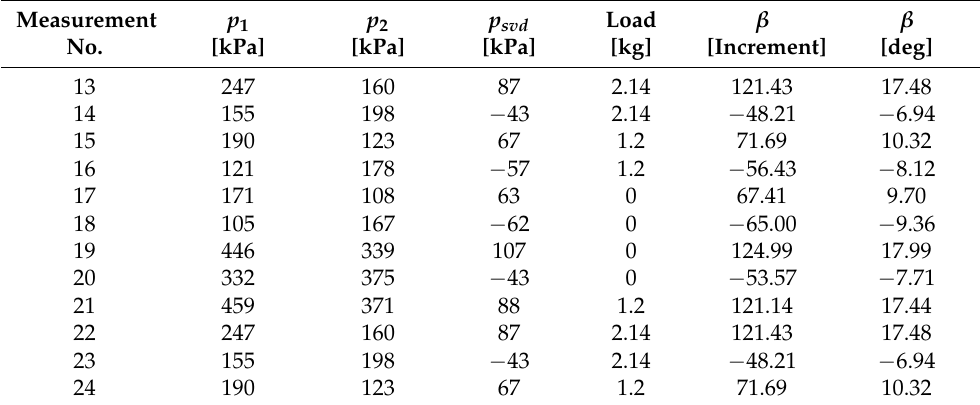
Figure 7. The actuator responses measured at large step changes of the input pressure. Table 2. Values of pressures in MAS 20–250 and actuator rotation at small step changes of the input pressure.